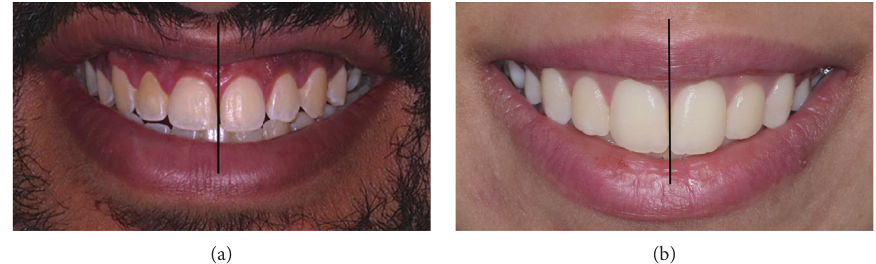
Figure 1: (a) Male subject showing no buccal corridor and no midline shift. (b) Female subject showing no buccal corridor and no midline shift.